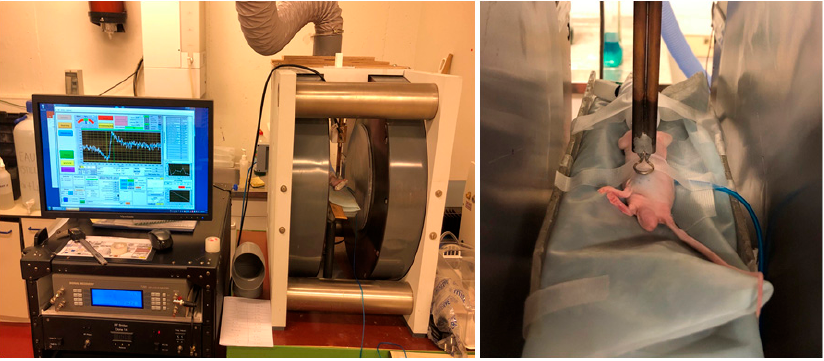
Figure 8. Setup for EPR oximetry measurements. ( Left ) 1 GHz EPR spectrometer. ( Right ) focus on the surface coil put at the surface of a tumor implanted in the leg of an anesthetized mouse.